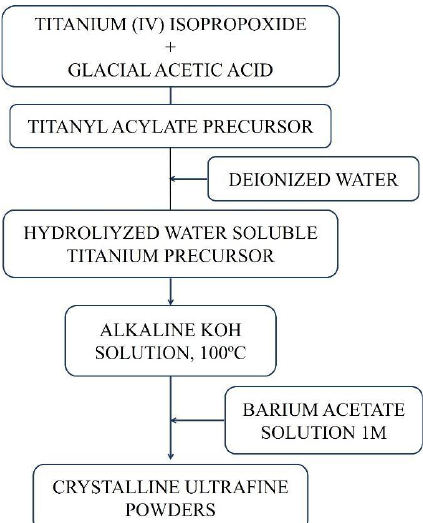
Figure 3. Diagram with the production stages of BaTiO 3 by the sol-precipitation method.